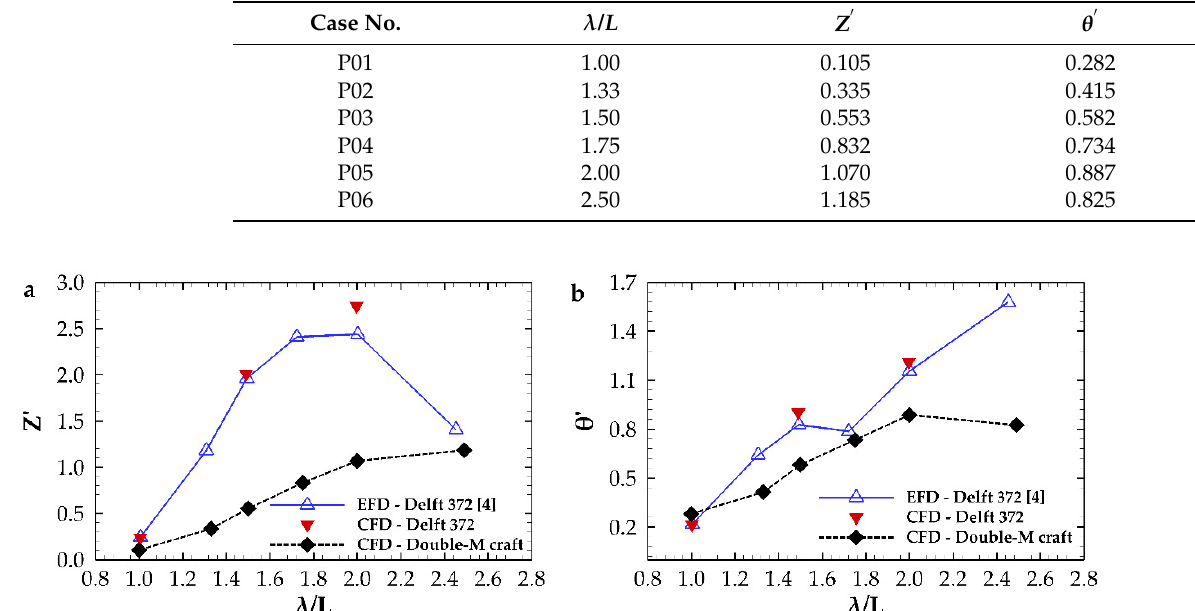
Figure 13. Heave and pitch motion responses of Delft 372 catamaran and Double-M craft with Fr = 0.7 in head sea waves: ( a ) Heave RAO. ( b ) Pitch RAO.